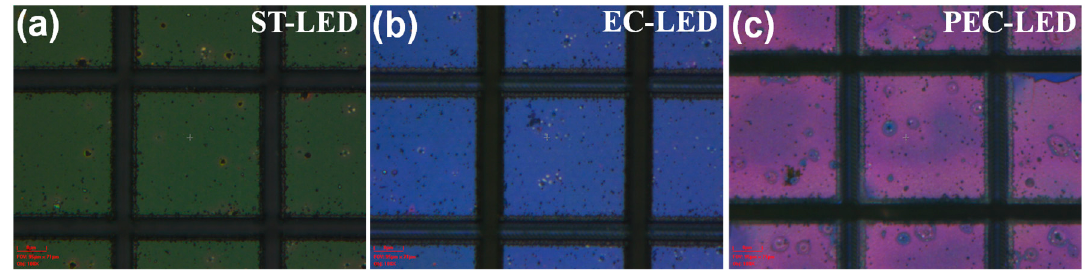
Figure 1. OM images of ( a ) ST-LED, ( b ) EC-LED, and ( c ) PEC-LED were observed with laser scribing line patterns. The mesa regions were 35 × 35